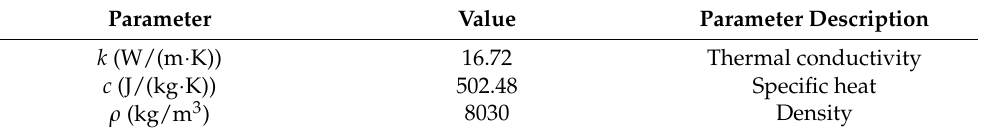
Table 1. Material properties of circular tube. Table 2. Parameters of hypersonic flow.